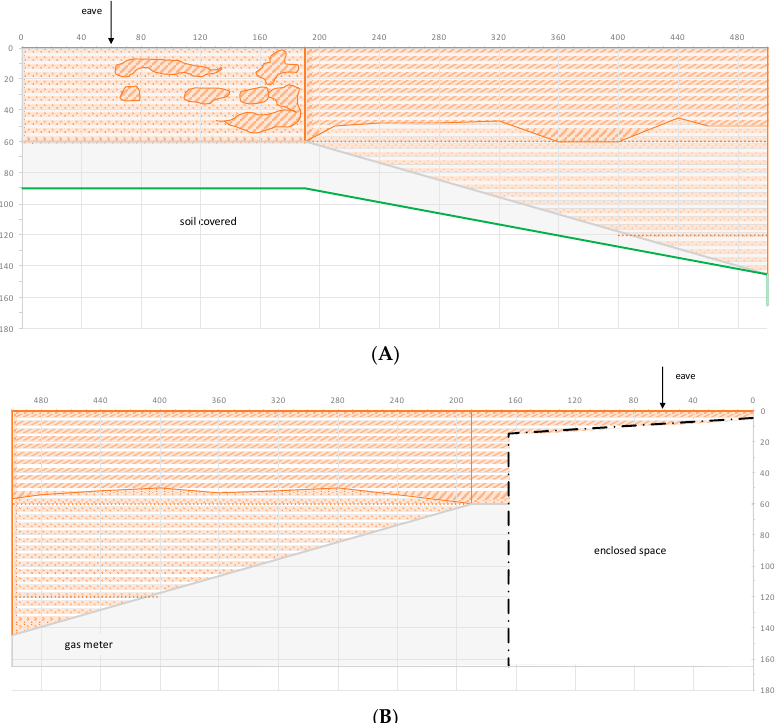
Figure 18. Schematic representation of the observed decay of wall 5: ( A ) eastern face; ( B ) western face. For the legend, see Figure 13.